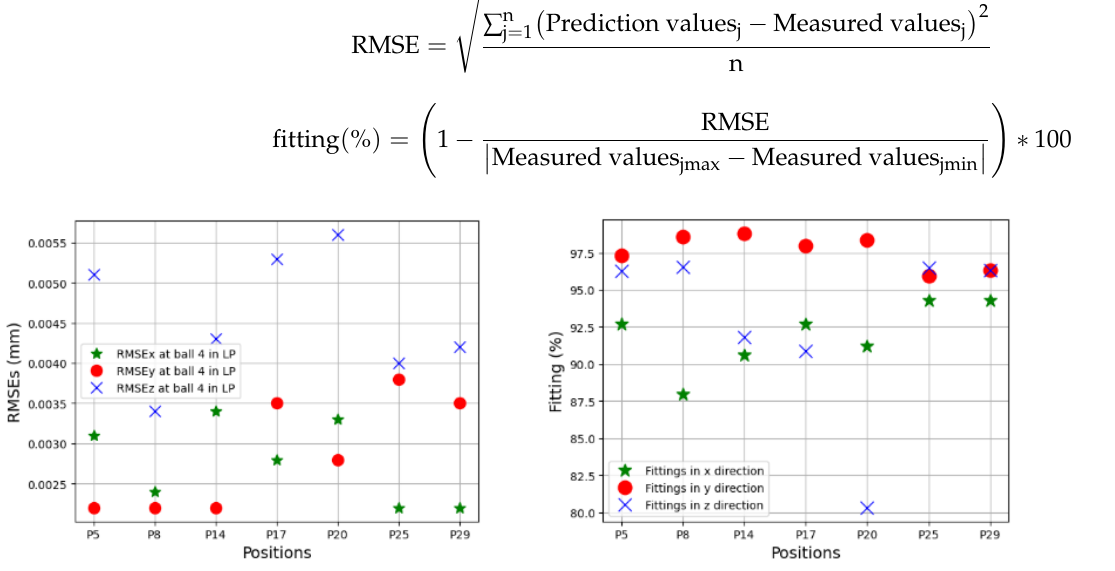
Figure 20. RMSEs and fi tt ings of seven positions at ball 4 in the long process (LP).